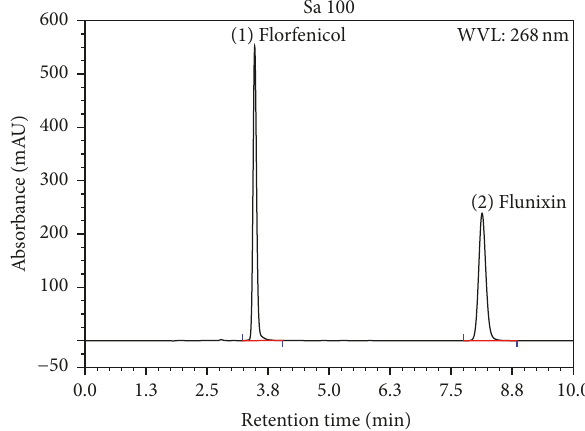
Figure 2: Chromatogram of Flr and Flx in drug product using the developed method in this